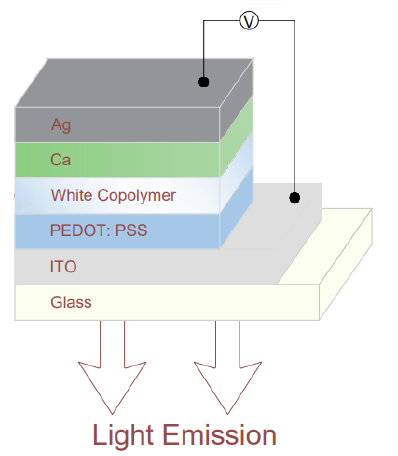
Figure 1. The architecture of the fabricated OLED devices.